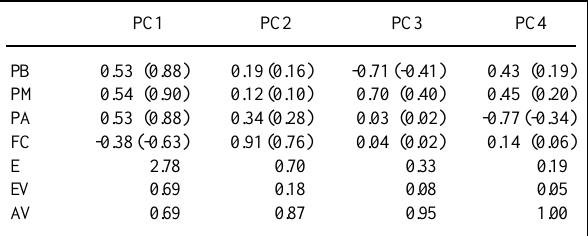
Correlation coefficient between the PC and each variable in parentheses. For abbreviations see legend to Table II.